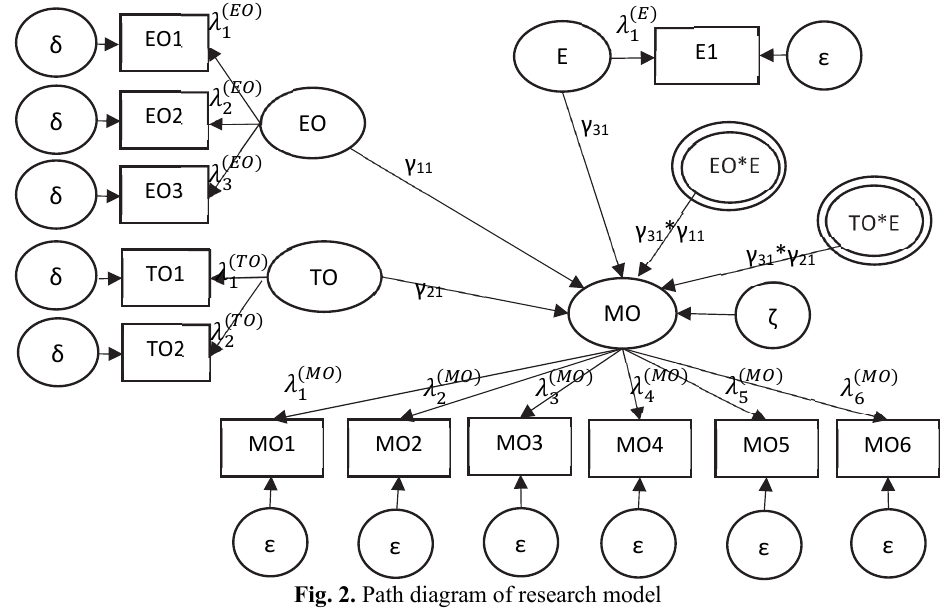
Fig. 2. Path diagram of research